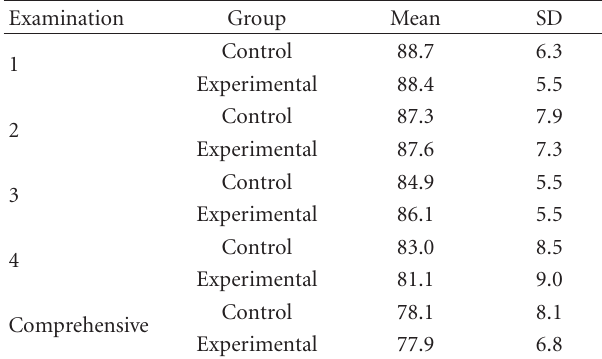
Table 2: Mean Scores for 2nd semester BSN student medical-surgi- cal